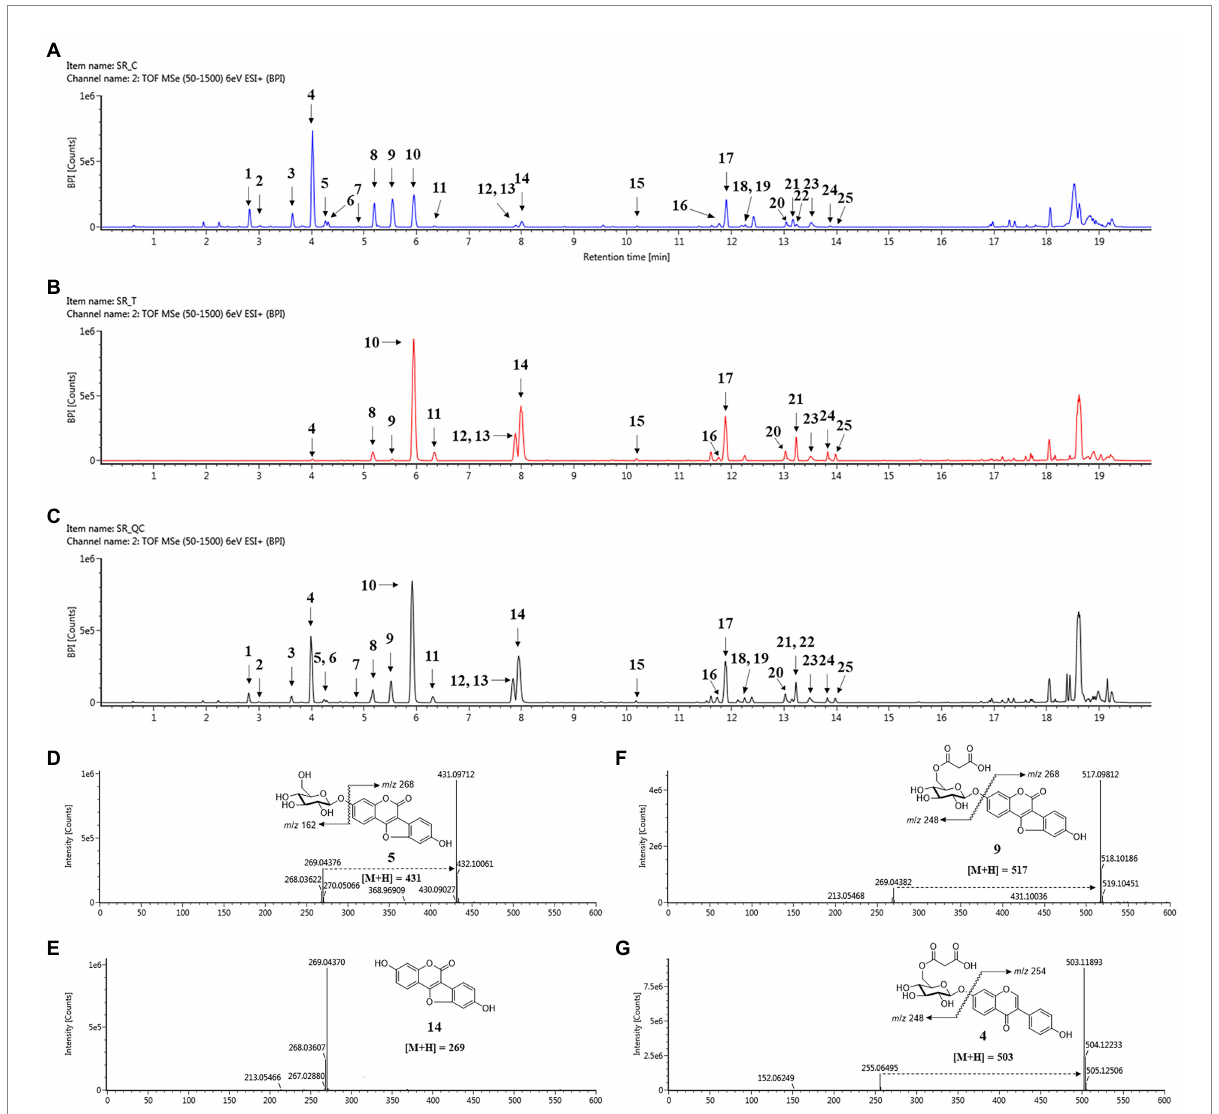
FIGURE 4 Changes in secondary metabolites of soybean roots by SA treatment. (A) BPI chromatogram of control soybean roots. (B) BPI chromatogram of SA treated soybean roots. (C) BPI chromatogram of quality control (QC). (D–G) Positive ion mass spectra of representative metabolites of soybean roots: (D) Coumestrin, (E) Malonylcoumestrin, (F) Coumestrol, (G) malonyldaidzin. Peak 1, daidzin; peak 2, glycitin; peak 3, genistin; peak 4, malonyldaidzin; peak 5, coumestrin; peak 6, malonylglycitin; peak 7, acetyldaidzin; peak 8, malonylgenistin; peak 9, malonylcoumestrin; peak